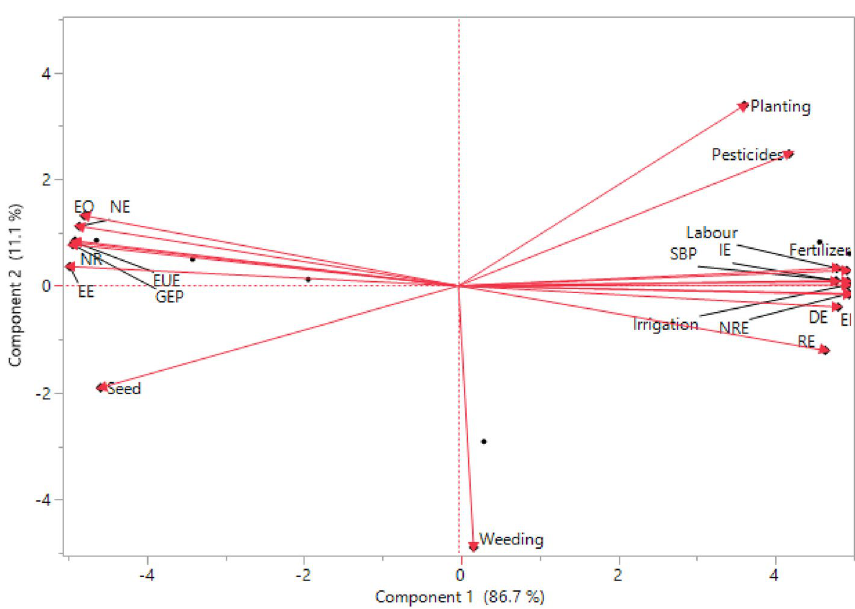
Figure 5. Principal component analysis among the energy and economic indicators under the RW system; Where; SBP seed bed preparation, DE direct energy, IE indirect energy, RE renewable energy, NRE non- renewable energy, EI energy input, EO energy output, NE net energy, EUE energy use efficiency, GEP grain energy productivity, NR net return, EE